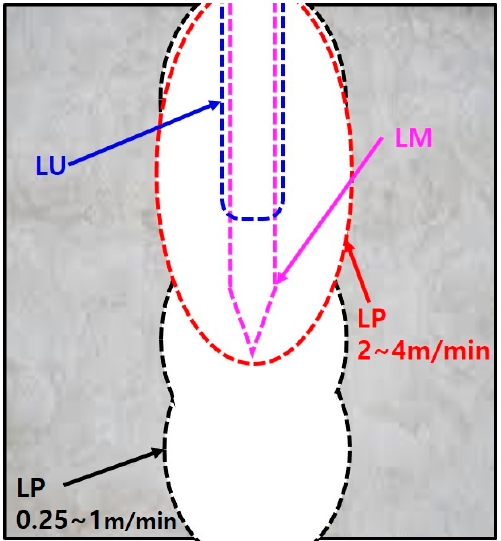
Figure 10. Schematic of penetration shapes of LP, LM, and LU series.